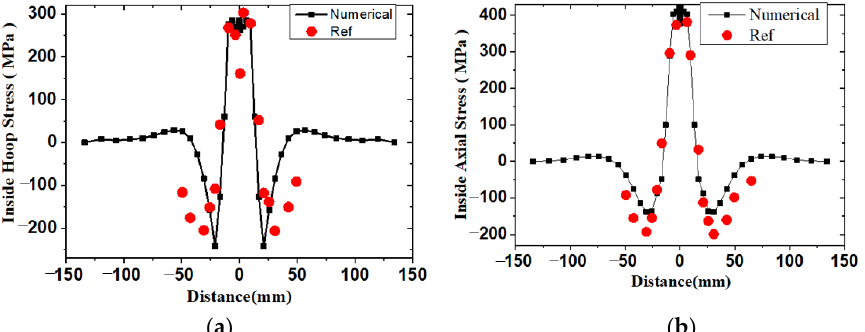
Figure 9. ( a ) Axial stress distribution on the inside surface, ( b ) Hoop stress distribution on the inside